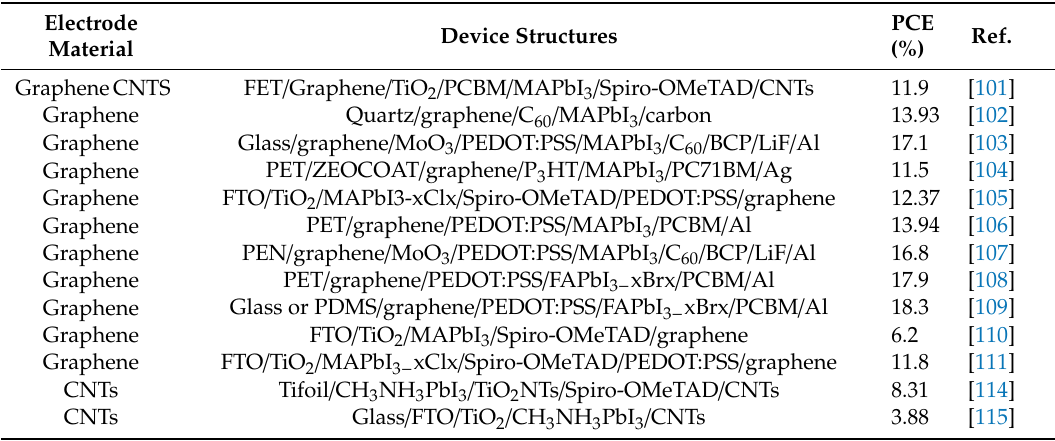
Table 3. Summary of the PSCs with graphene and CNTs electrodes